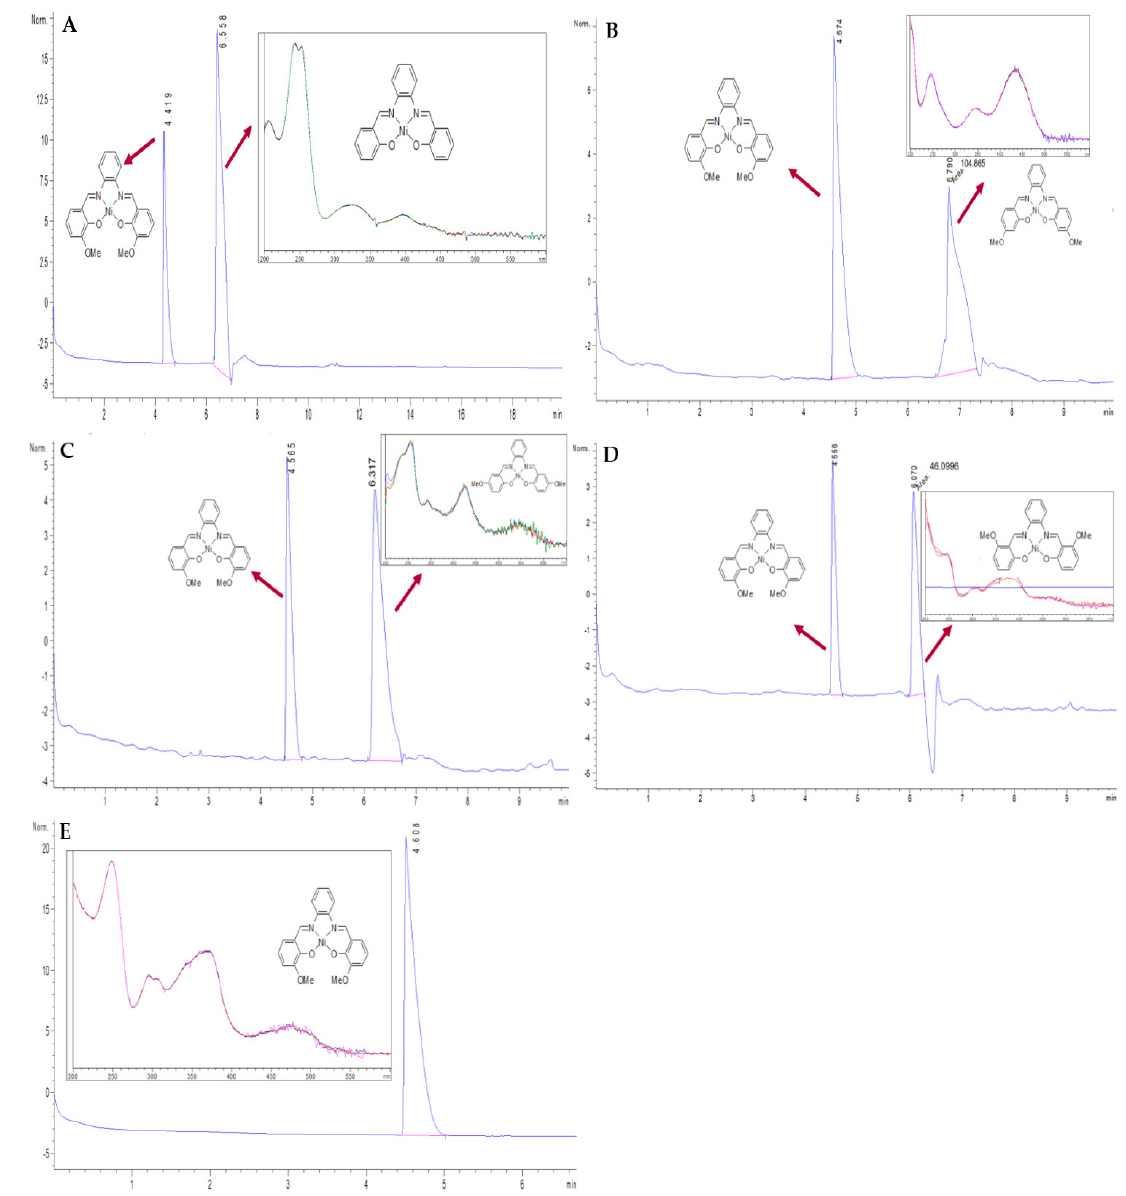
Figure 2. Electropherograms for the separation of Ni II (3-OMe-salophene) from ( A ) Ni II (salophene), ( B ) Ni II (4-OMe-salophene), ( C ) Ni II (5-OMe-salophene), and ( D ) Ni II (6-OMe-salophene) at concentrations 400 ng mL − 1 ; ( E ) Ni II (3-OMe-salophene) alone (2000 ng mL − 1 ). CZE condition: BGE; 50 mM buffer borate, pH 9.3, and ACN (50:50, v / v ); 30 kV separation voltages; Temperature 25 °C; Hydrodynamic injection under pressure of 50 mbar for 8 s.